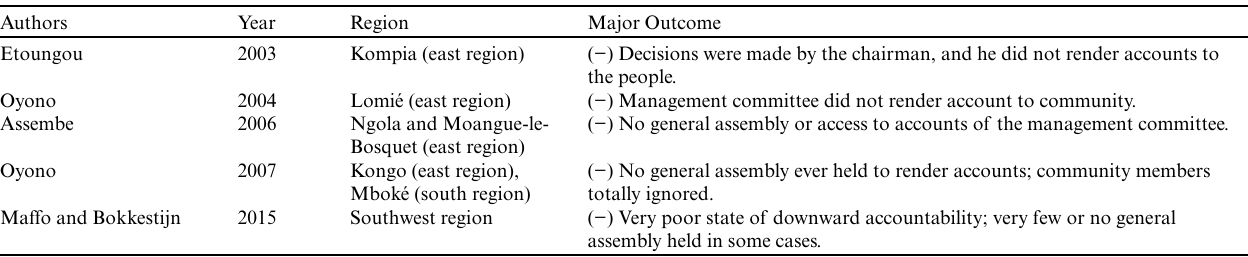
Table 4 . Accountability of community forests in Cameroon.